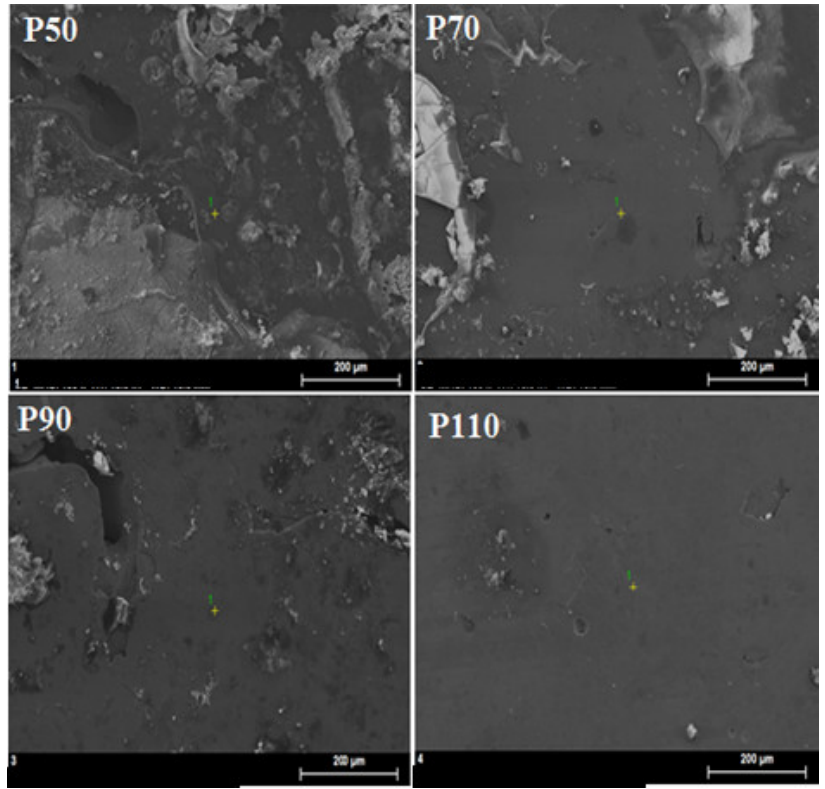
Figure 8. Morphology of the selective laser melted samples.